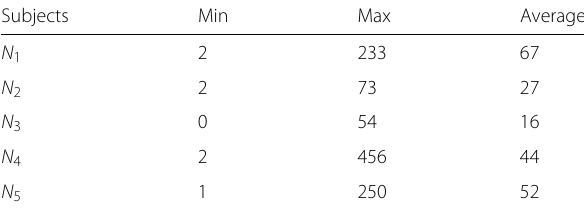
Table 7 Latency effects on T 2 : difference in p 2 features calculated from local timestamps compared with features derived from respective network timestamps